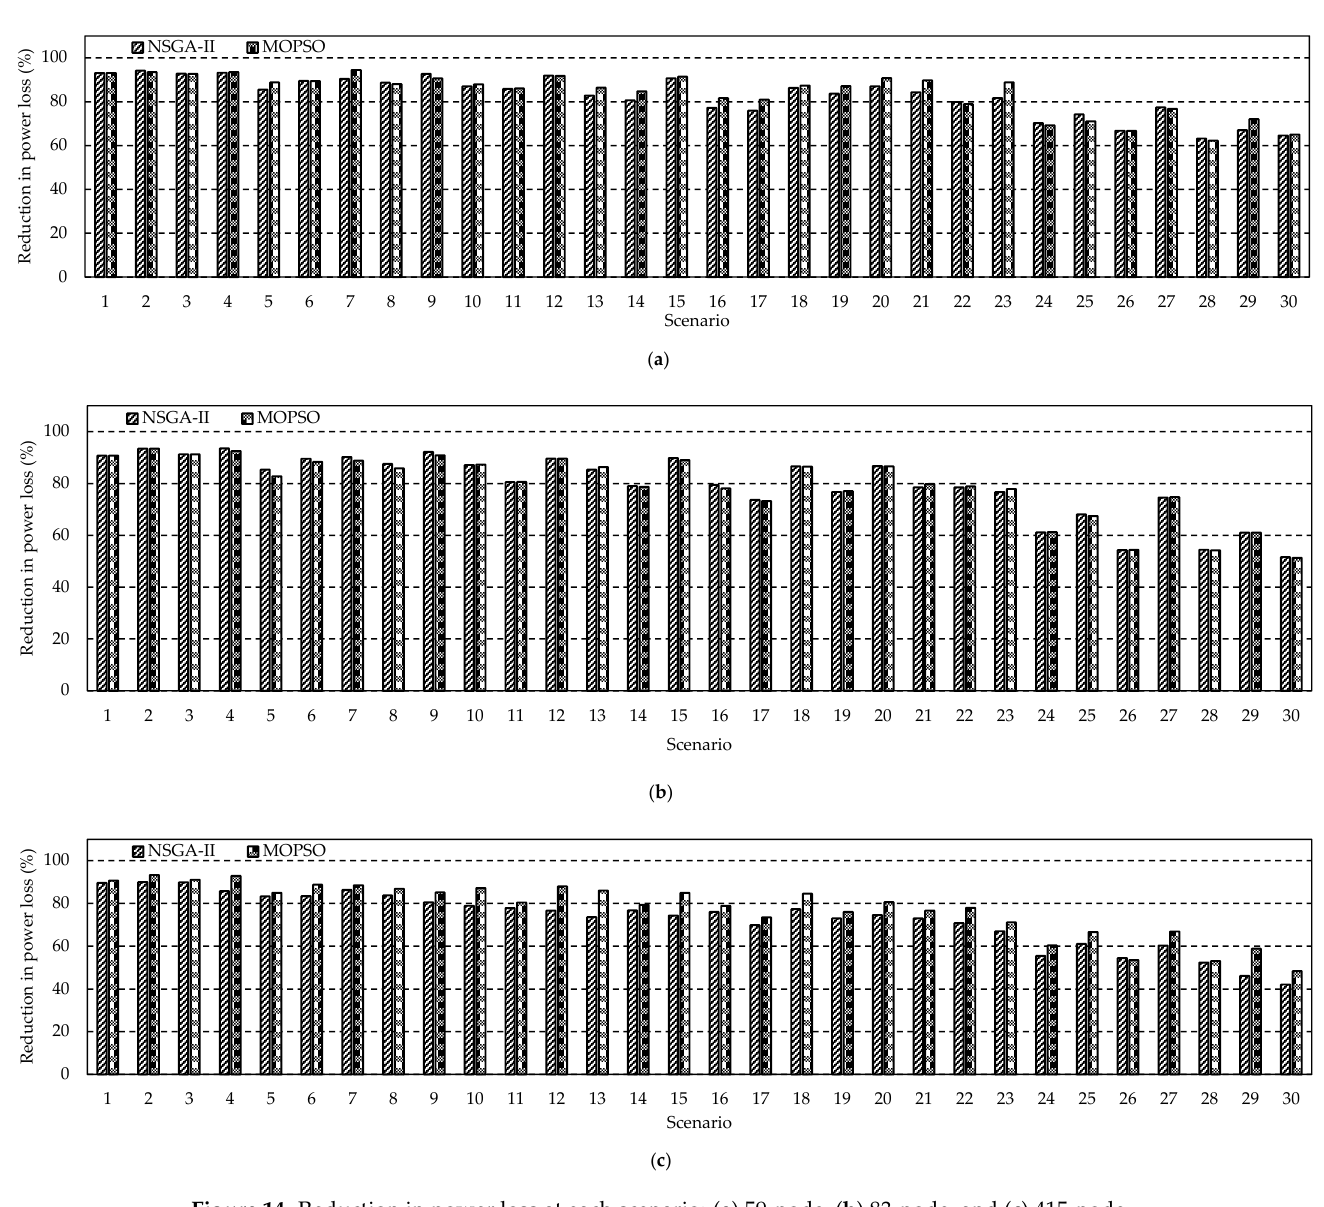
Figure 14. Reduction in power loss at each scenario: ( a ) 59-node, ( b ) 83-node, and ( c ) 415-node.